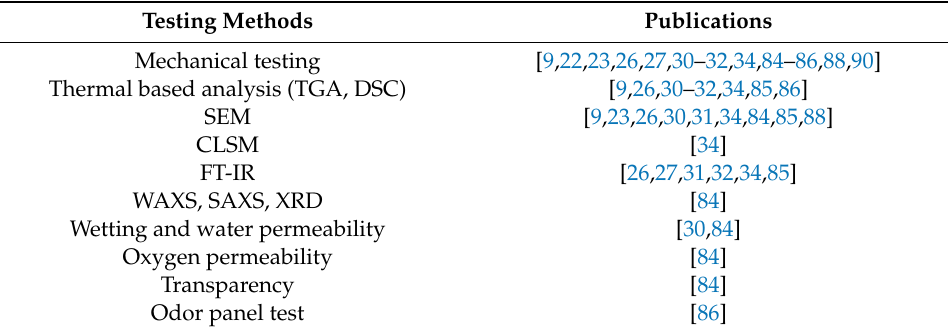
Table 10. Summary of testing methods for microalgae–polymer blend